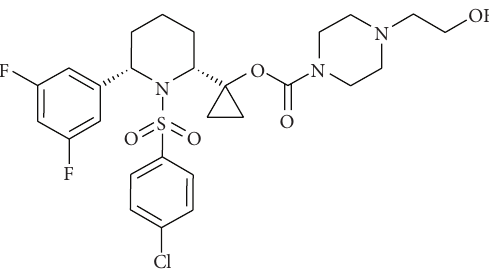
Figure 1: SCH 697466: 1-[cis-1-[(4-chlorophenyl)sulfonyl]-6-(3,5- difluorophenyl)-2-piperidinyl]cyclopropyl 4-(2-hydroxyethyl)-1- piperazinecarboxylate